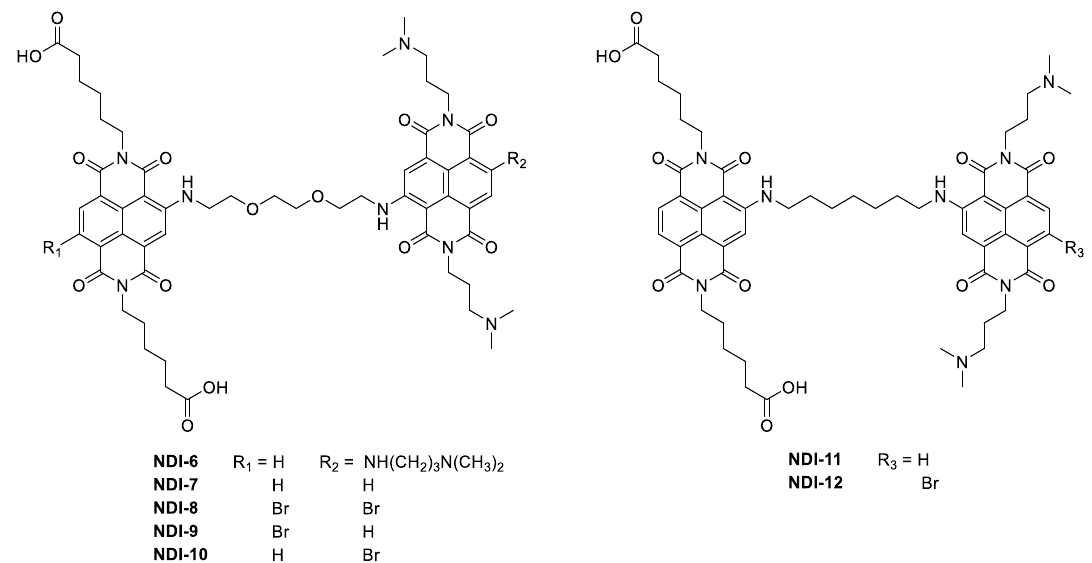
Figure 1. Chemical structures of the monomeric naphthalene diimides here investigated.